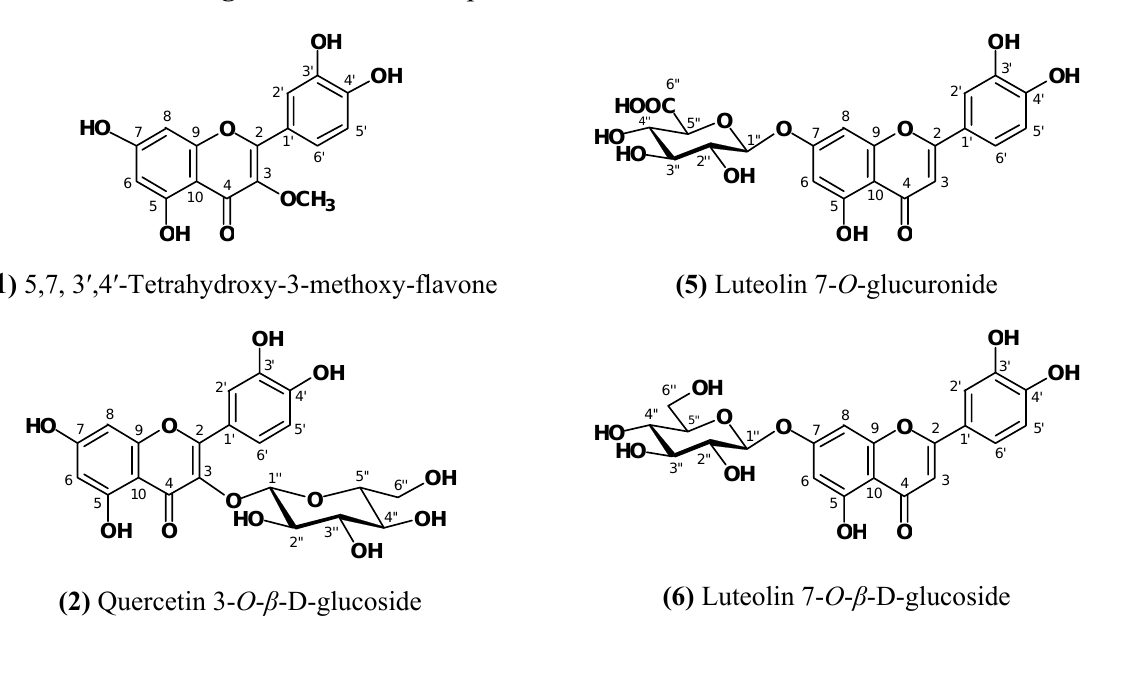
Figure 1. Isolated compounds from Sonchus erzincanicus